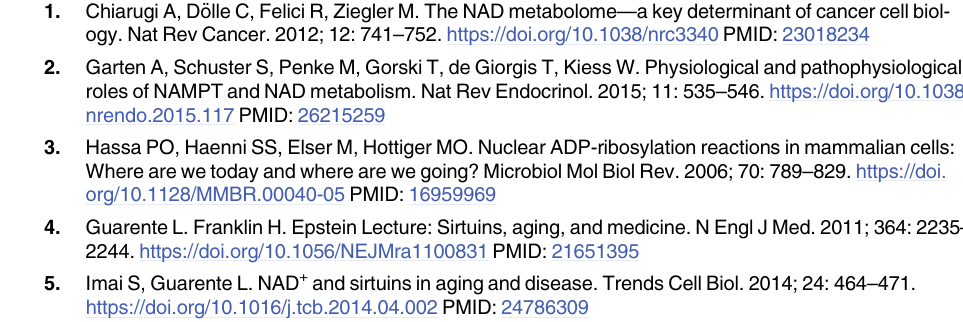
S6 Fig. Effects of induction of Nampt on the expression of NAD + -consuming enzymes. HeLa cell lysates used in Exp1-3 in S4 Fig were subjected to Western blot analysis to determine the expression of PARP1, PARP2, SIRT1, and CD38 with anti-human PARP1 monoclonal (1:1000 dilution, Santa Cruz, sc-74469), anti-human PARP2 polyclonal (1:10000 dilution, Active Motif, 39744), anti-human SIRT1 monoclonal (1:10000, Cell Signaling, #8469), and anti-human CD38 monoclonal (1:1000 dilution, Santa Cruz, sc-374650) antibodies, respec-